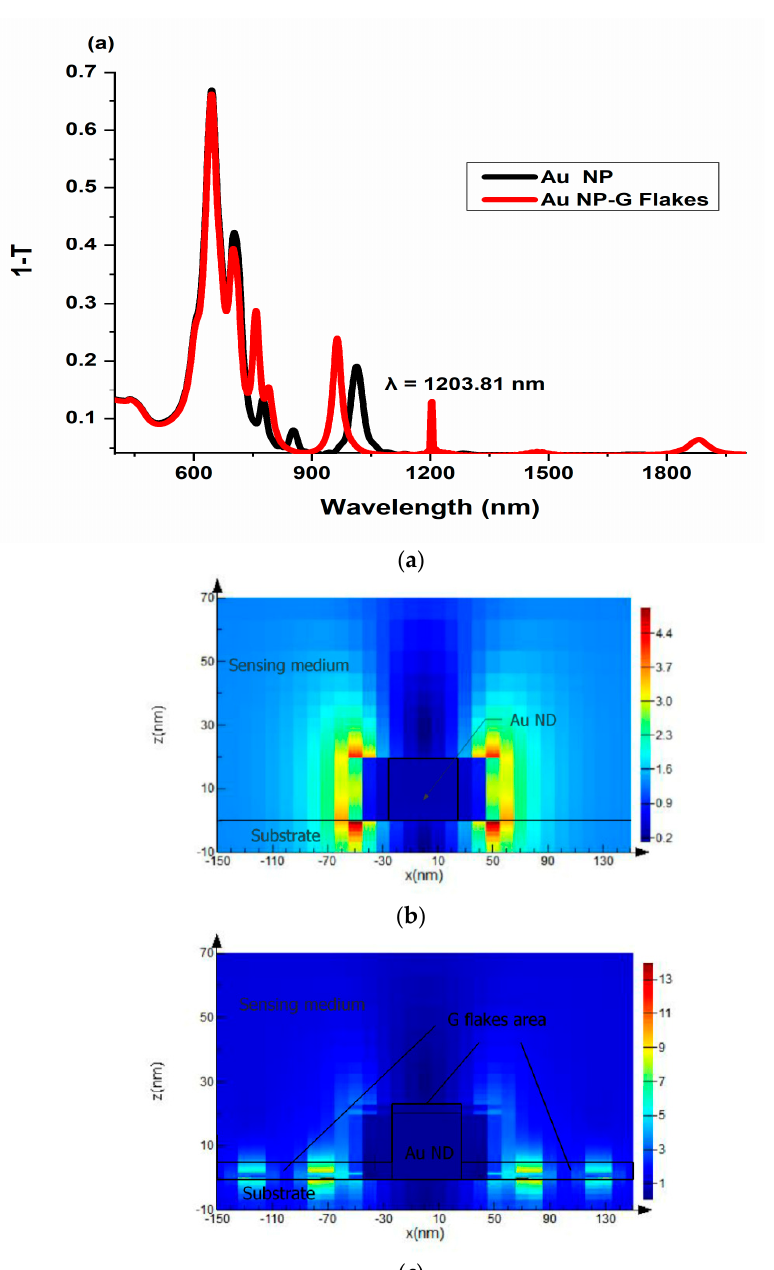
Figure 3. Absorption spectra of Au ND array and Au-G flakes hybrid nanostructure ( a ), and the cross section (x-z axis) electric field profile of Au ND array ( b ) and Au-G hybrid nanostructure ( c ) at λ = 1203.81 nm.